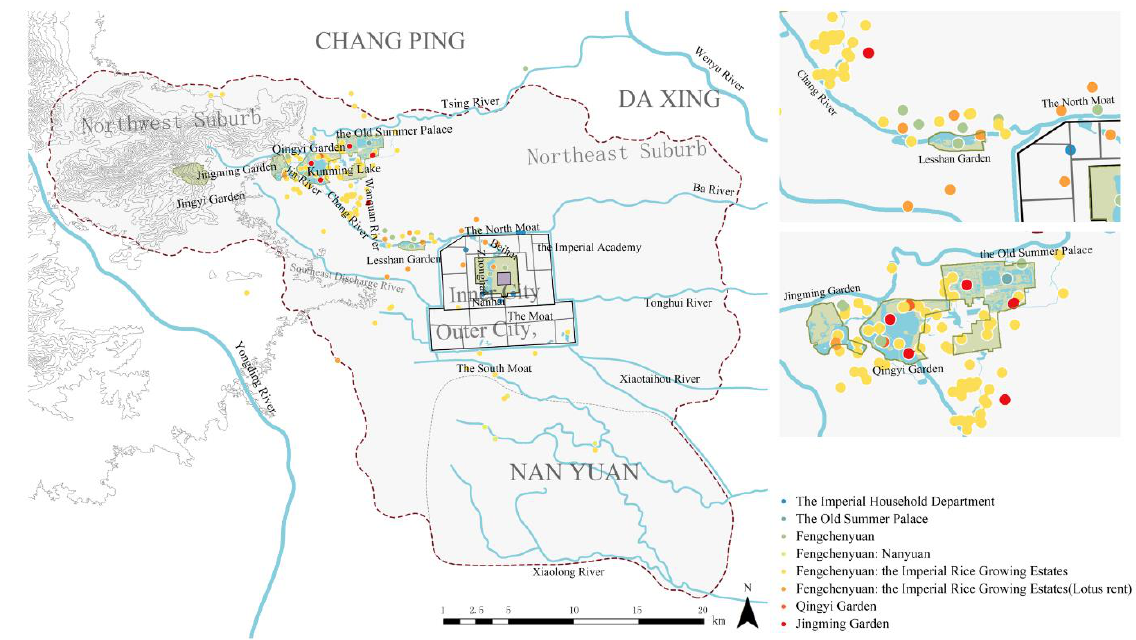
Figure 16. Map of management organization and plot location.